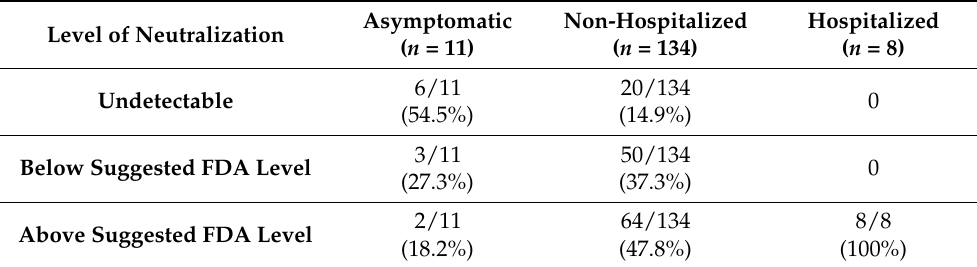
Figure 3. Neutralizing SARS-CoV-2 IgG, IgA, and IgM antibodies against S protein and RBD were found in variable levels in resolved and RT-PCR-negative study participants. Neutralizing SARS-CoV-2 antibody titers from resolved subjects ( n = 153) were measured in the microneutralization assay and compared to ( A ) anti-S protein and ( B ) anti-RBD IgG antibody levels as measured in the SARS-CoV-2 ELISA. Neutralizing antibody titers are expressed as geometric MNT50 values (y-axis). ELISA values are shown as a ratio of observed optical density to the determined assay cut-off optical density (x-axis). ( C ) Neutralizing SARS-CoV-2 antibody titers from resolved subjects ( n = 153) were measured in the microneutralization assay and were compared to their days since symptom onset. X-axis is expressed in log 10 . Values above 1 ratio are considered positive in the SARS-CoV-2 ELISA. Table 3. Level of neutralization in asymptomatic, non-hospitalized and hospitalized resolved COVID- 19